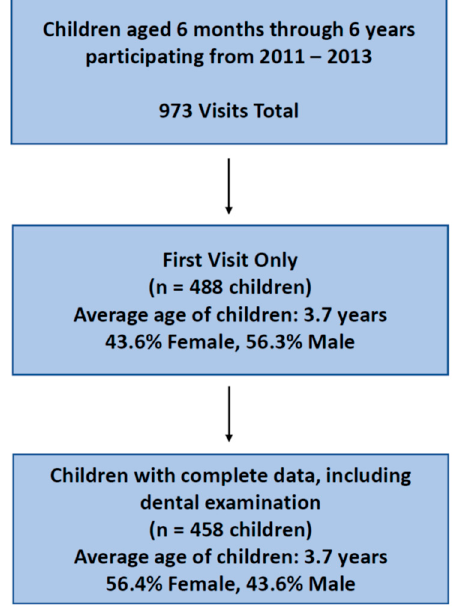
Figure 1. Analytic Figure 1. Analytic Sample.